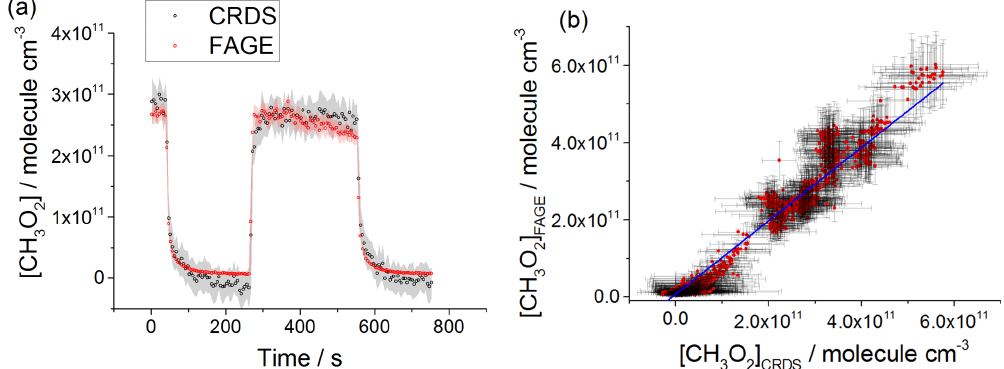
Figure 7. Comparison of CH 3 O 2 measurement (a) and the correlation plot at 100mbar of N 2 / O 2 (4 : 1) (b) . In both figures [CH 3 O 2 ] FAGE was computed using a calibration factor of 2 . 80 × 10 − 9 countscm 3 molecule − 1 s − 1 mW − 1 and [CH 3 O 2 ] CRDS was determined using a cross section of 1 . 49 × 10 − 20 cm 2 molecule − 1 . Each point is a value averaged over 5s. Panel (a) shows the measurement by FAGE (red) and the measurement by CRDS (black) where the CH 3 O 2 radicals were generated by the photolysis of Cl 2 (2 . 5 × 10 15 moleculecm − 3 ) in the presence of CH 4 (2 . 4 × 10 16 moleculecm − 3 ) and O 2 . The UV black lamps were alternately switched on and off: the lamps were turned off at t ∼ 40s and then turned on at t ∼ 250s for ∼ 5min before being switched off again. The 1 σ statistical errors generated by the data averaging are shown as grey (CRDS) and red (FAGE) shadows. Panel (b) combines the data obtained using acetone/O 2 and 254nm lamps with the data generated using Cl 2 /CH 4 / O 2 and UV black lamps. [CH 3 O 2 ] measured by FAGE is plotted versus [CH 3 O 2 ] measured by CRDS. The linear fit to the data is obtained using the orthogonal distance regression algorithm and results in a gradient of 0 . 95 ± 0 . 02 and an intercept of ( 7 . 0 ± 0 . 4 ) × 10 9 moleculecm − 3 ; fit errors given at the 2 σ